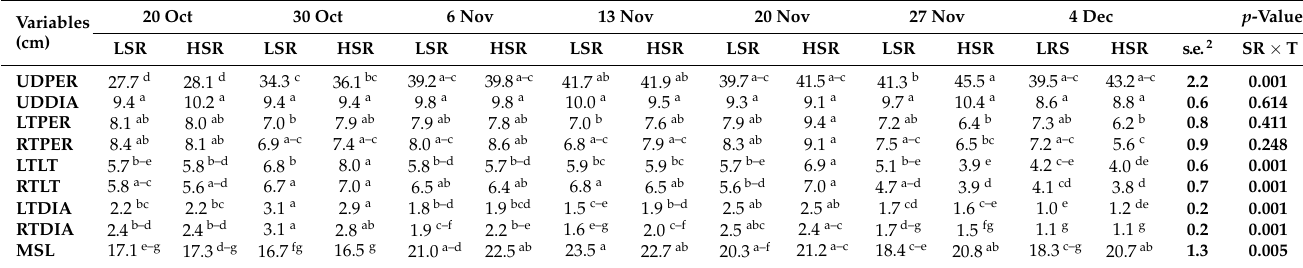
Table 3. Least-square means ± s.e. for the interaction social rank (i.e., LSR and HSR) and time (i.e., 7 times) for goat udder morphometric components considering udder perimeter (UDPER, cm), udder diameter (UDDIA, cm), left-teat perimeter (LTPER, cm), right-teat perimeter (RTPER, cm), left-teat length (LTLT, cm), right-teat length (RTLT, cm), left-teat length diameter (LTDIA, cm), right-teat diameter (RTDIA, cm), and medium suspensory ligament (MSL, cm) in crossbred (Alpine–Saanen– Nubian × Criollo; n = 15) dairy goats in northern Mexico (25 ◦ N) 1,2 .